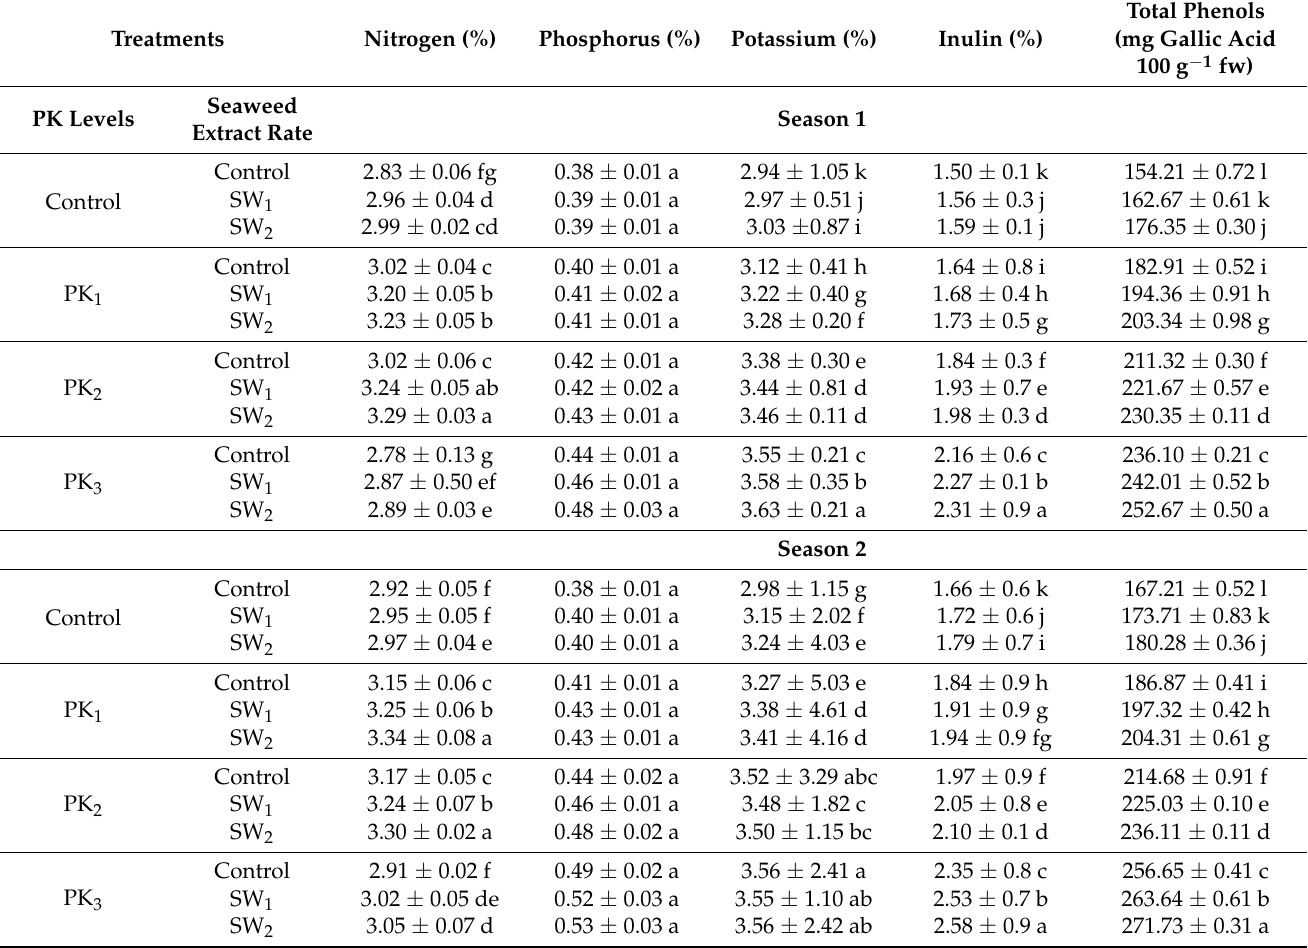
Table 5. Head mineral contents and quality of globe artichoke as affected by interaction between PK fertilizer levels and seaweed extract